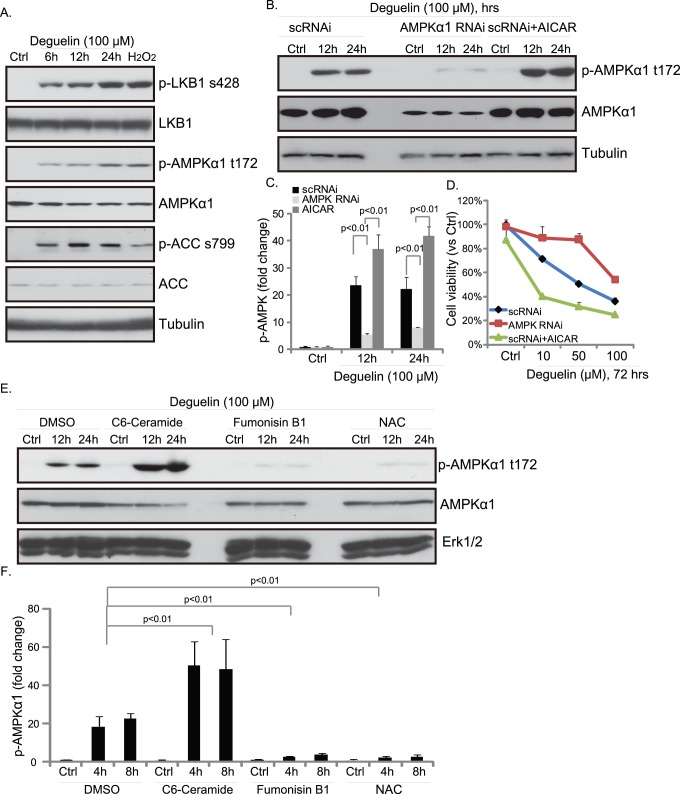
Deguelin activates AMPK signaling.Hep-2 cells were exposed to 100 µM of deguelin for indicated time points, followed by western blot detecting phospho- and total- level of LKB1-AMPK-ACC using specific antibodies (A). Hep-2 cells were transfected with scramble or AMPKα1RNAi (100 nM each) for 48 hours. Western blot was utilized to test AMPKα1 expression after transfection. Successfully AMPK knockdown cells and their parental cells were treated with deguelin (100 µM) in the presence or absence of AICAR (1 mM), phospho- and total- level of AMPKα1 were analyzed in (B–C), MTT assay was then used to test cell viability after 48 hours (D). Hep-2 cells were pretreated with fumonisin B1 (20 µM), C6-ceramide (10 µg/ml) or NAC (500 µM) for 1 hr before deguelin exposure for indicated time points, phospho- and total level of AMPKα1 as well as tubulin were tested by western blots (E–F). The mean of at least three independent experiments performed in triplicate is shown. Statistical significance was analyzed by ANOVA.